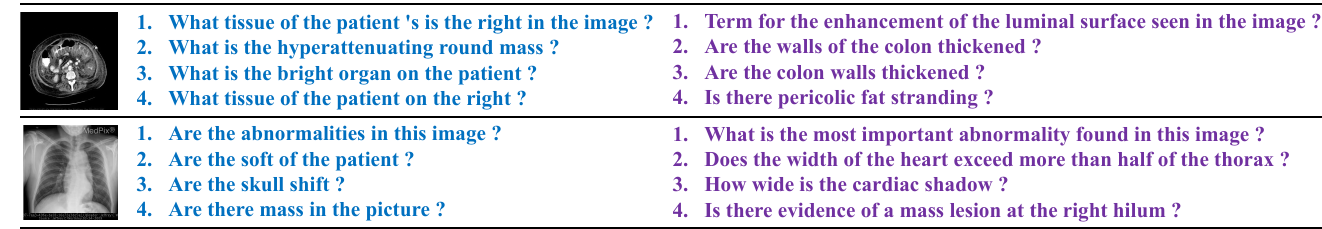
Figure 6. ( a – c ) are samples of the generated questions from a single image of our model with a different number of latent spaces. Questions generated from different spaces have lower Similarity than that of questions generated by the previous models shown in Table 2. Different spaces can be assumed to learn different knowledge, allowing for various questions to be